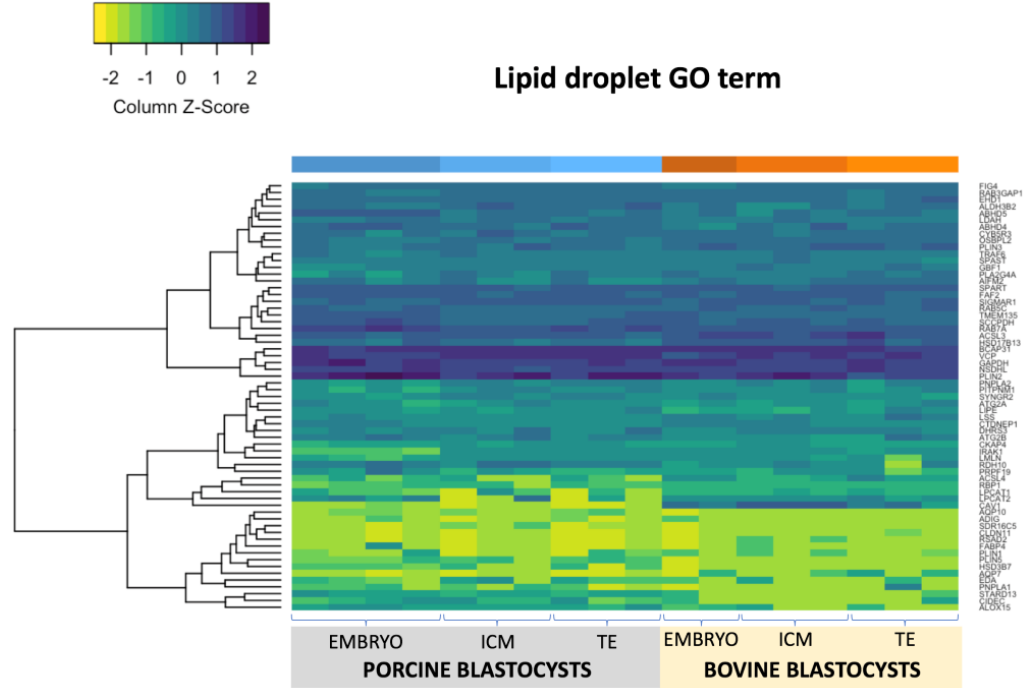
Figure 3. Heatmap of gene ontology (GO) term “lipid droplet” representing porcine and bovine parthenogenetic, blastocyst stage embryos, inner cell mass (ICM) and trophoblast (TE) cell lines.